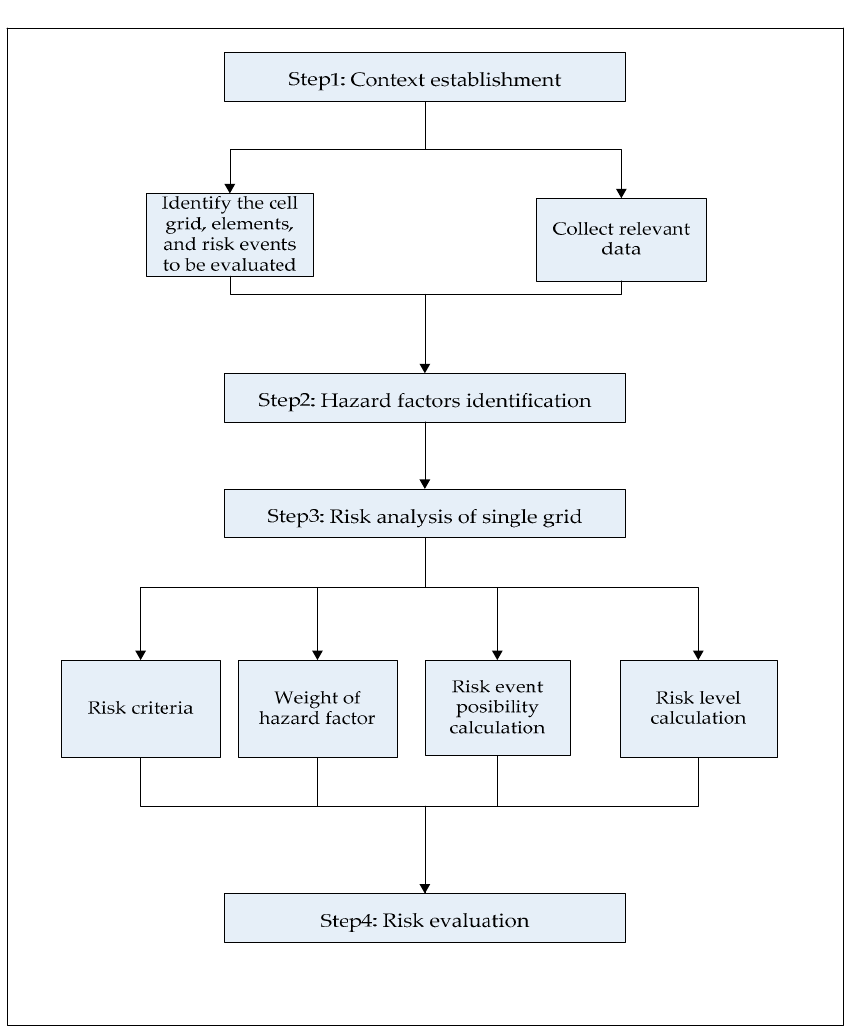
Figure 6. Grid-based risk assessment model.